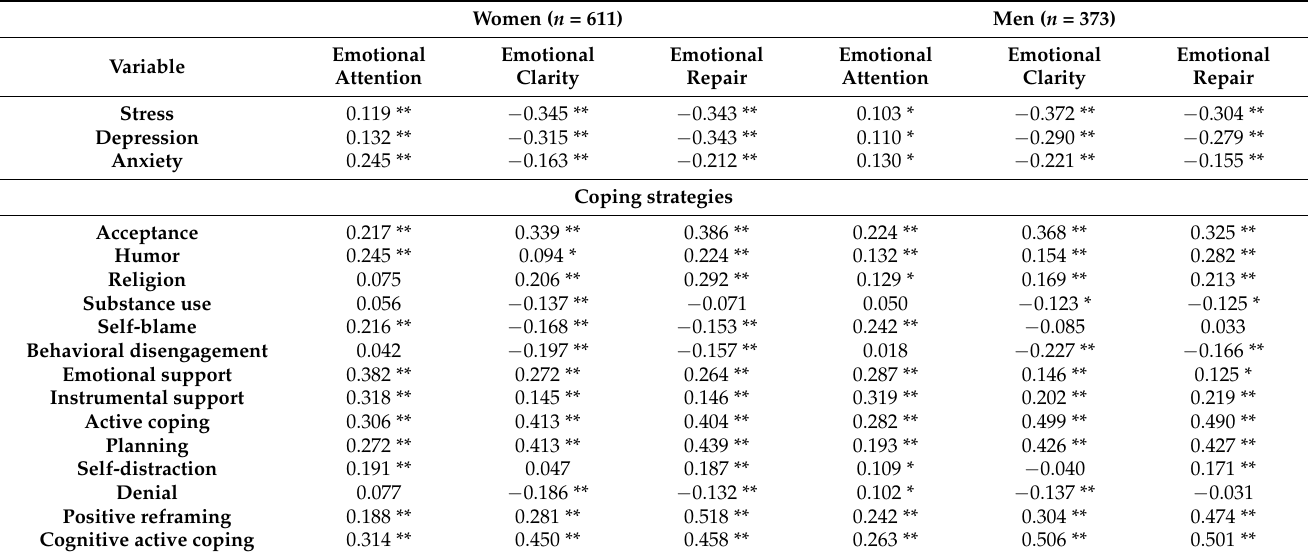
Table 4. Correlations between emotional intelligence and coping strategies in each